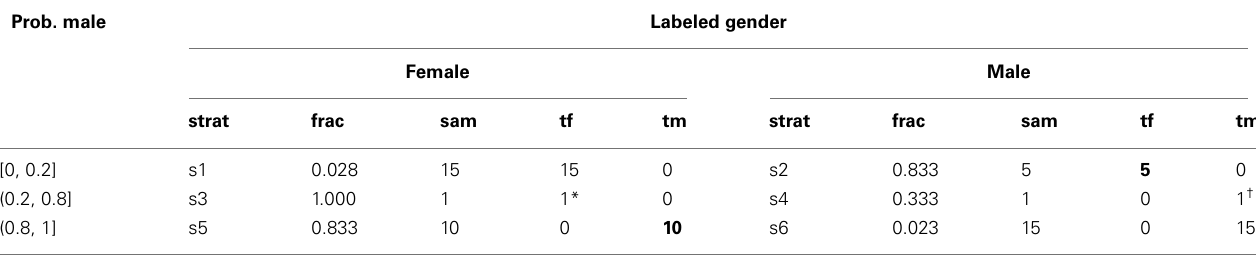
Table 2 | Stratum labels (strat), second-phase sampling fractions (frac), numbers in second-phase sample (sam = frac × tot, where tot is given inTable 1), and true gender counts (tf = true female, tm = true male, tf + tm = sam). Prob.